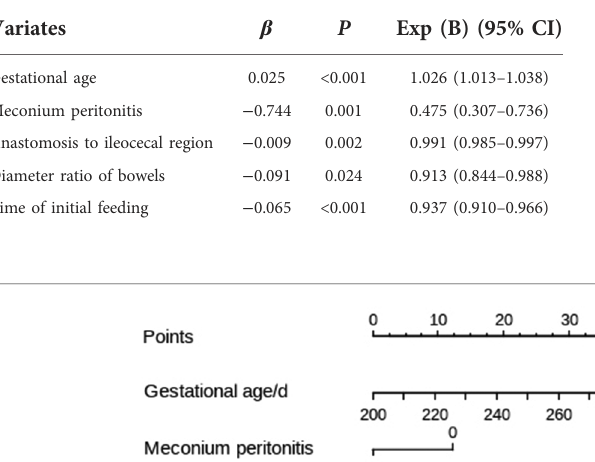
TABLE 3 Multivariate cox regression analysis for prediction model.